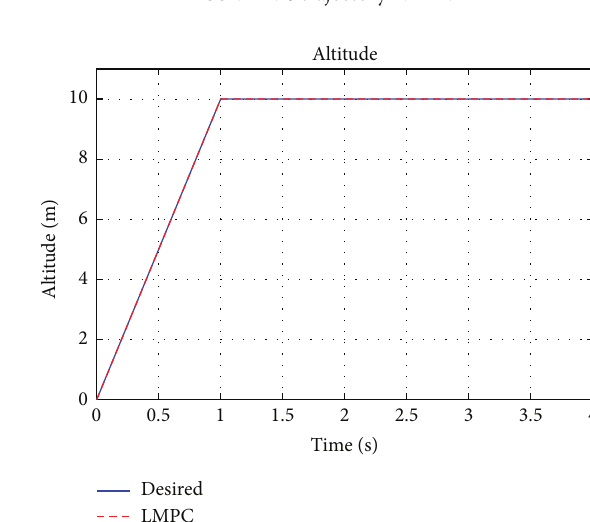
Figure 9: 𝑥 trajectory 𝑁 = 9 .